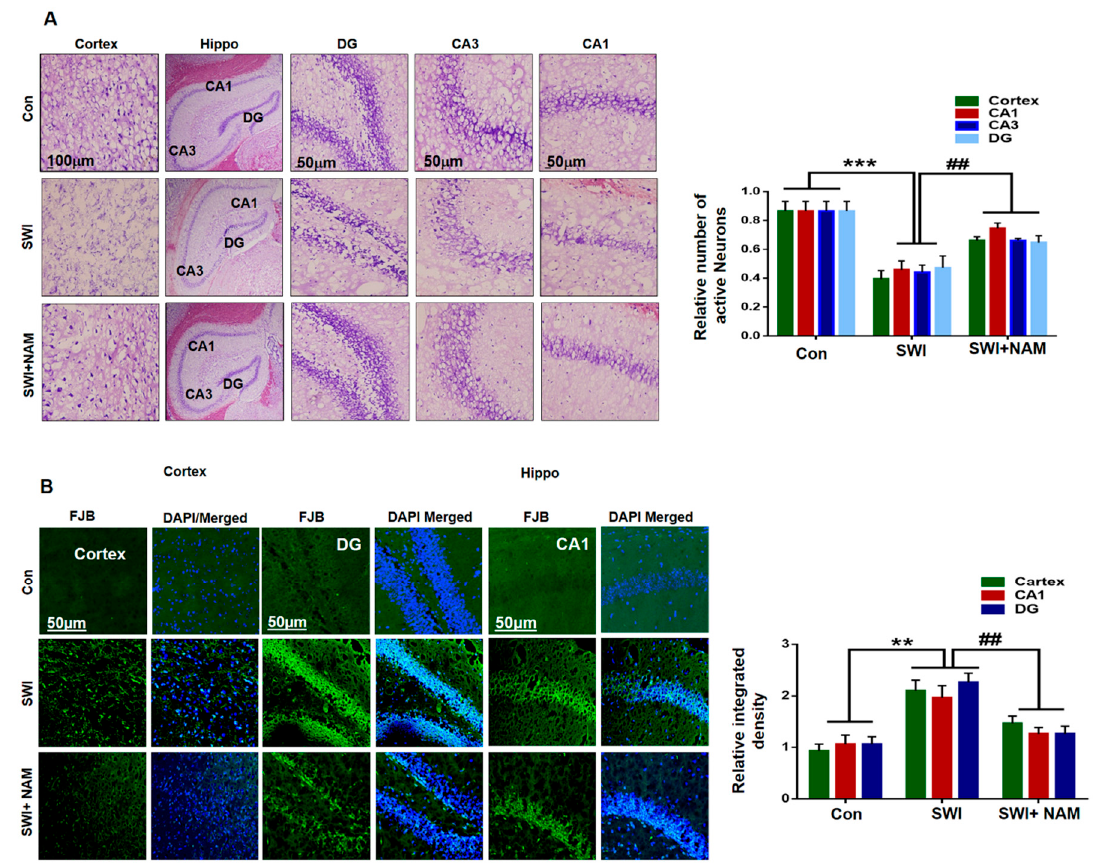
Figure 6. NAM reduced the injury-induced neuronal apoptosis in the mouse cortex. ( A ) Representatives images Figure 5. NAM reduced the injury-induced neuronal apoptosis in the mouse cortex. ( A ) are the confocal microscopy images of Nissl staining in the cortex and hippocampal Cornu Ammonis 1 (CA1), Representatives images are the confocal microscopy images of Nissl staining in the cortex and CA3, and Dentate gyrus (DG) regions among the treated groups. ( B ) Confocal images of Fluoro-Jade B (FJB) hippocampal Cornu Ammonis 1 (CA1), CA3, and Dentate gyrus (DG) regions among the treated +ve (dead) neuronal cells (Magnification X10). ImageJ software was used for images quantification. Values represent the mean ± SEM. All values were taken from three independent experiments. Statistical analysis was done through one-way ANOVA analysis. P < 0.05 was considered to be statistically significant. The symbols * P < 0.05, ** P < 0.01, and *** P < 0.001 represent significant differences between the control and SWI; # P < 0.05, and ## P < 0.01 represent significance differences between SWI and SWI plus